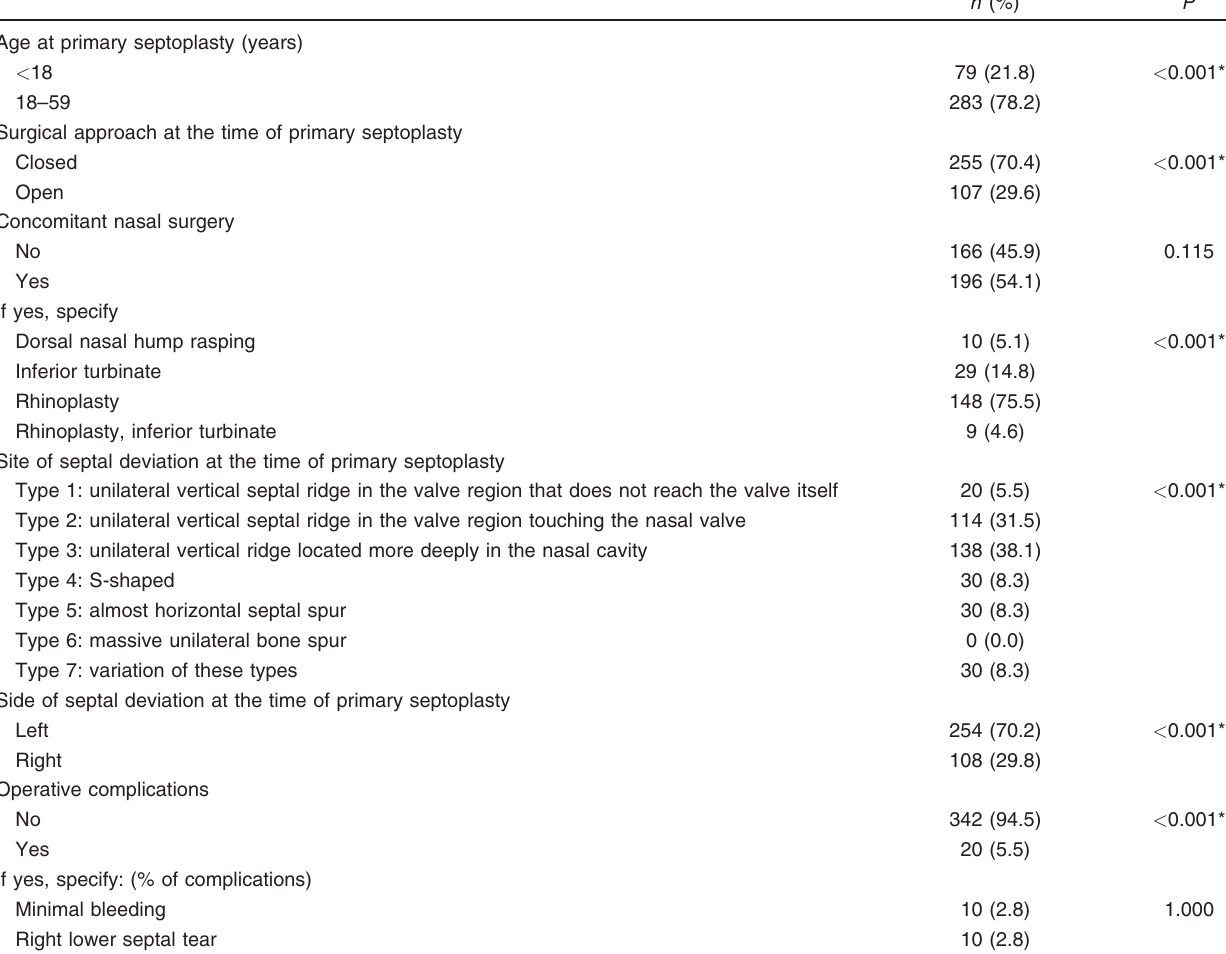
Table 2 Characteristics of the studied patients at the time of first (primary) septoplasty ( n = 362)